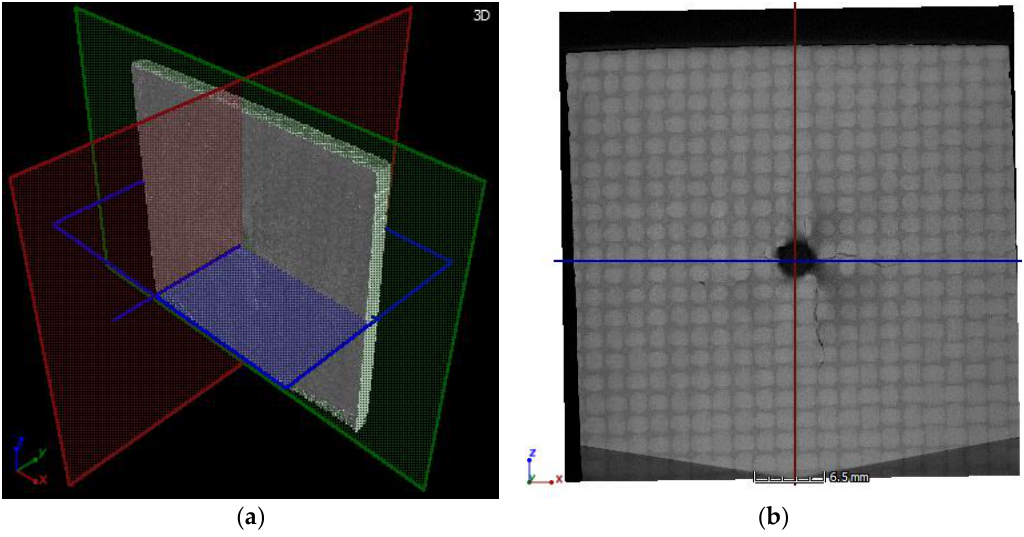
Figure 5. The X-ray computed tomography (CT) results: ( a ) a 3D view; ( b ) an exemplary front section.